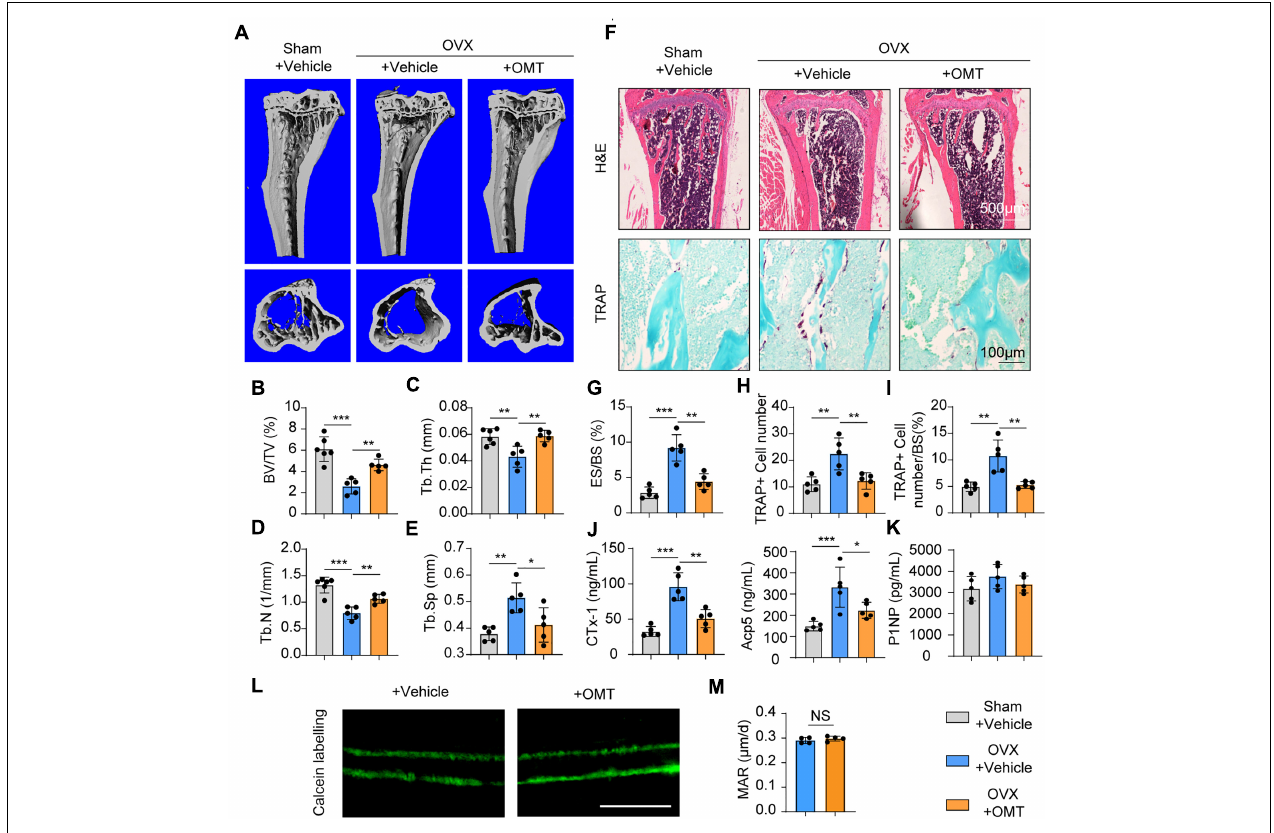
FIGURE 6 | OMT ameliorates OVX-induced bone loss by inhibiting osteoclast formation and activity. (A) Representative micro-CT images of tibias from Sham + vehicle, OVX + vehicle and OVX + 10 mg/kg OMT groups. (B–E) Quantitative analyses of parameters regarding bone microstructure, including BV/TV, Tb.Th, Tb.N, and Tb.Sp. (F) Representative images of H&E staining and TRAP staining from three groups were shown. (G–I) Quantitative analyses of the percentage of eroded surface/bone surface (ES/BS), TRAP-positive cell number, and TRAP-positive cell number/bone surface. (J) Serum concentrations of CTx-1 and Acp5 from different groups. (K) Serum concentrations of P1NP from different groups. (L) Representative images of calcein labeling from the vehicle and OMT groups. Scale bar = 5 µ m. (M) Quantification of mineral apposition rates (MAR). Data were presented as means ± SD of 5 independent experiments. * p < 0.05, ** p < 0.01, *** p <